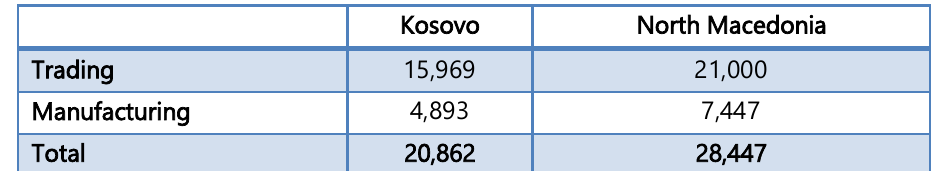
Table 1: Number of the research population (Source: Kosovo Statistics Agency; State Statistical Agency of North